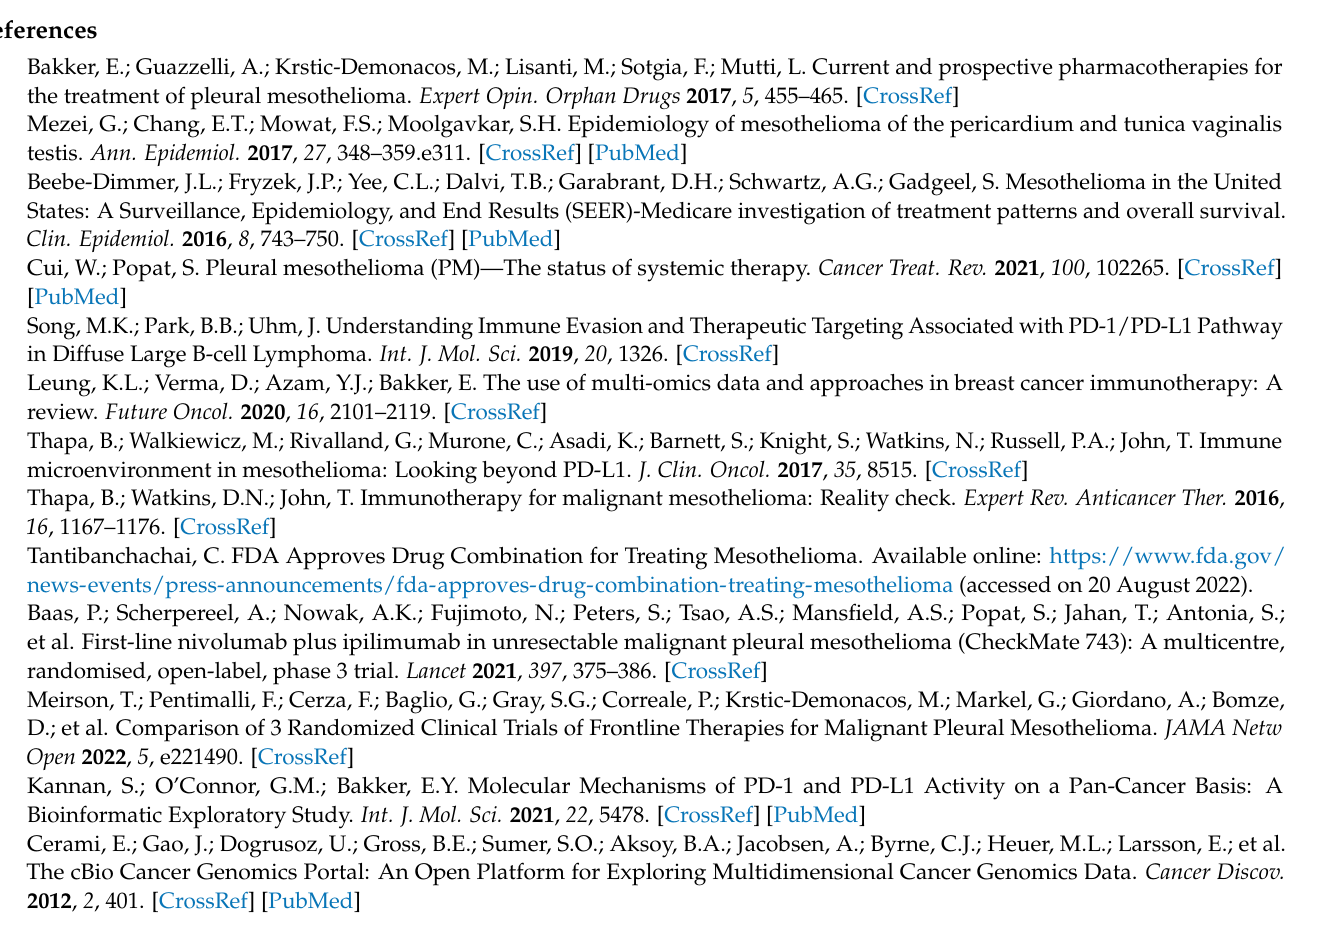
Figure S5: Co-expression analysis of PDCD1 and CD274 with GZMA; Figure S6: Co-expression analysis of PDCD1 and CD274 with TBC1D10C; Table S1: Kaplan-Meier curve p-values obtained from cBioPortal and Benjamini-Hochberg adjusted p-values; Table S2: Node degree distribution for the PDCD1/CD274 network as identified by STRING